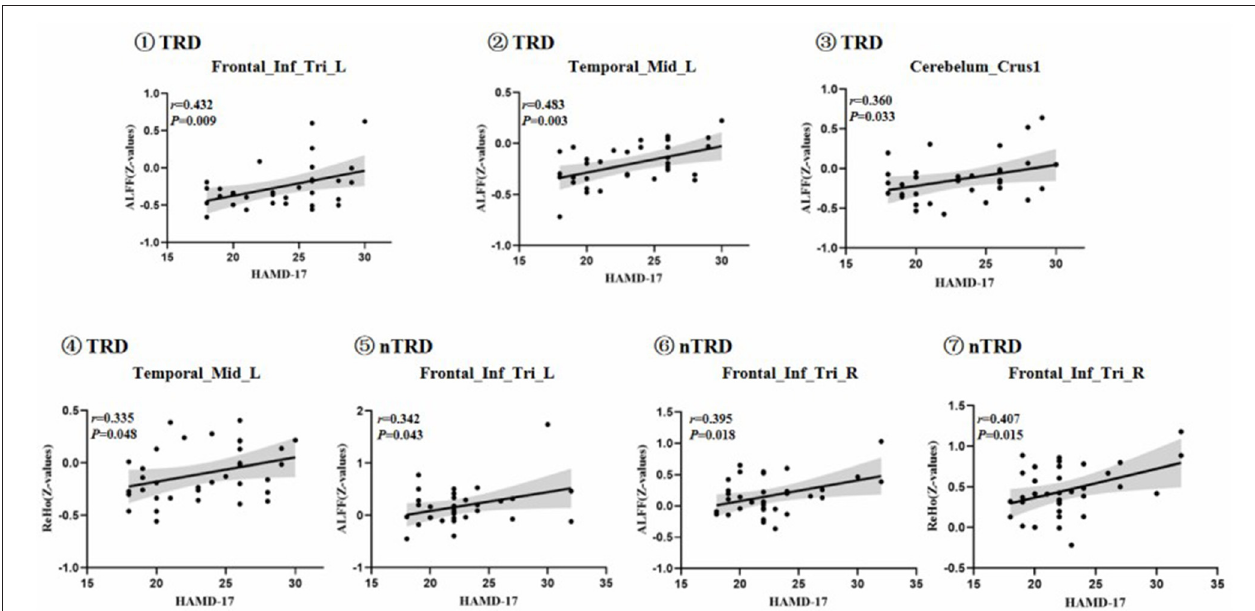
FIGURE 6 | Positive correlation between the ALFF and ReHo of the abnormal brain regions: ‹ Frontal_Inf_Tri_L, Left inferior frontal triangular gyrus; ALFF value of TRD group; › Temporal_Mid_L, left middle temporal gyrus; ALFF value of TRD group; fi Cerebelum_Crus1, bilateral posterior lobes of the cerebellum(Crus I); ALFF value of TRD group; fl Temporal_Mid_L, left middle temporal gyrus; ReHo value of TRD group; (cid:176) Frontal_Inf_Tri_L, Left inferior frontal triangular gyrus; ALFF value of nTRD group; – Frontal_Inf_Tri_R, Right inferior frontal triangular gyrus; ALFF value of nTRD group; † Frontal_Inf_Tri_R, Right inferior frontal triangular gyrus; ReHo value of nTRD